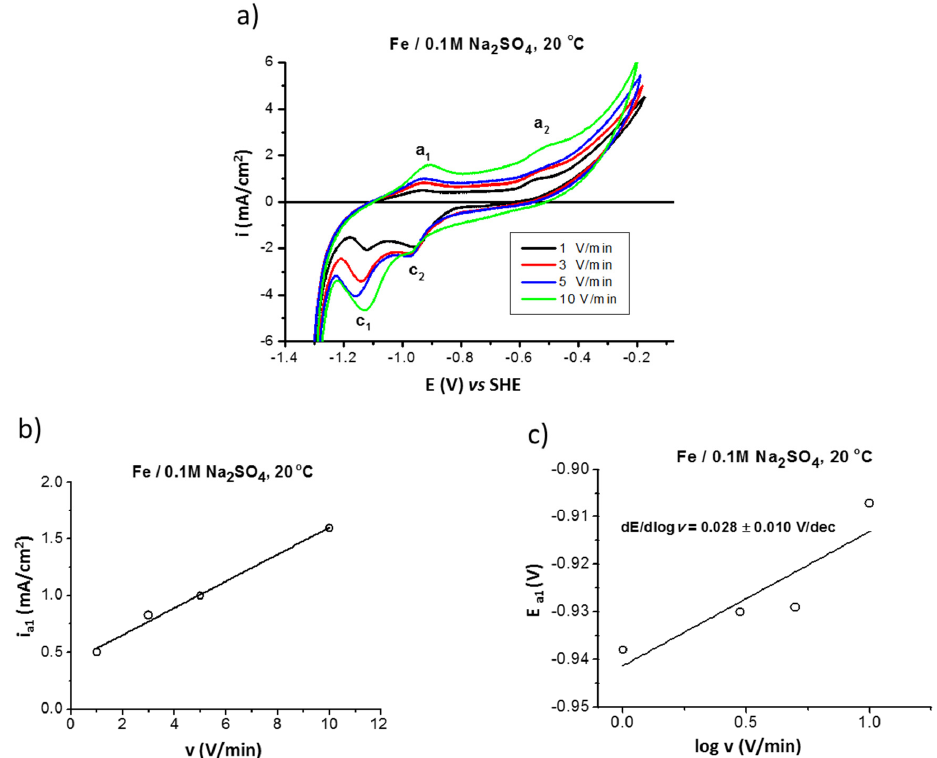
Figure 1. Polarization (CV) curves of iron in 0.1 M Na 2 SO 4 saturated with argon at 20 °C performed at different scan rates v = 1, 3, 5, and 10 V/min ( a ); influence of scan rate on anodic current density i a1 ( b ); and on anodic peak potential E a1 ( c ).